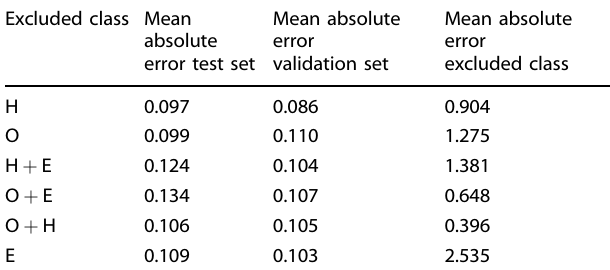
Table 1. Mean absolute error for the different ML models excluding a class of charge carrier type from training, testing, or validation set The mean absolute error for the predicted log(conductivities) of the excluded charge carrier class is also shown. The predicted conductivities are maximum one order of magnitude off for the ionic and ionic – electronic conductors and about two orders of magnitude off for the electronic conductors.